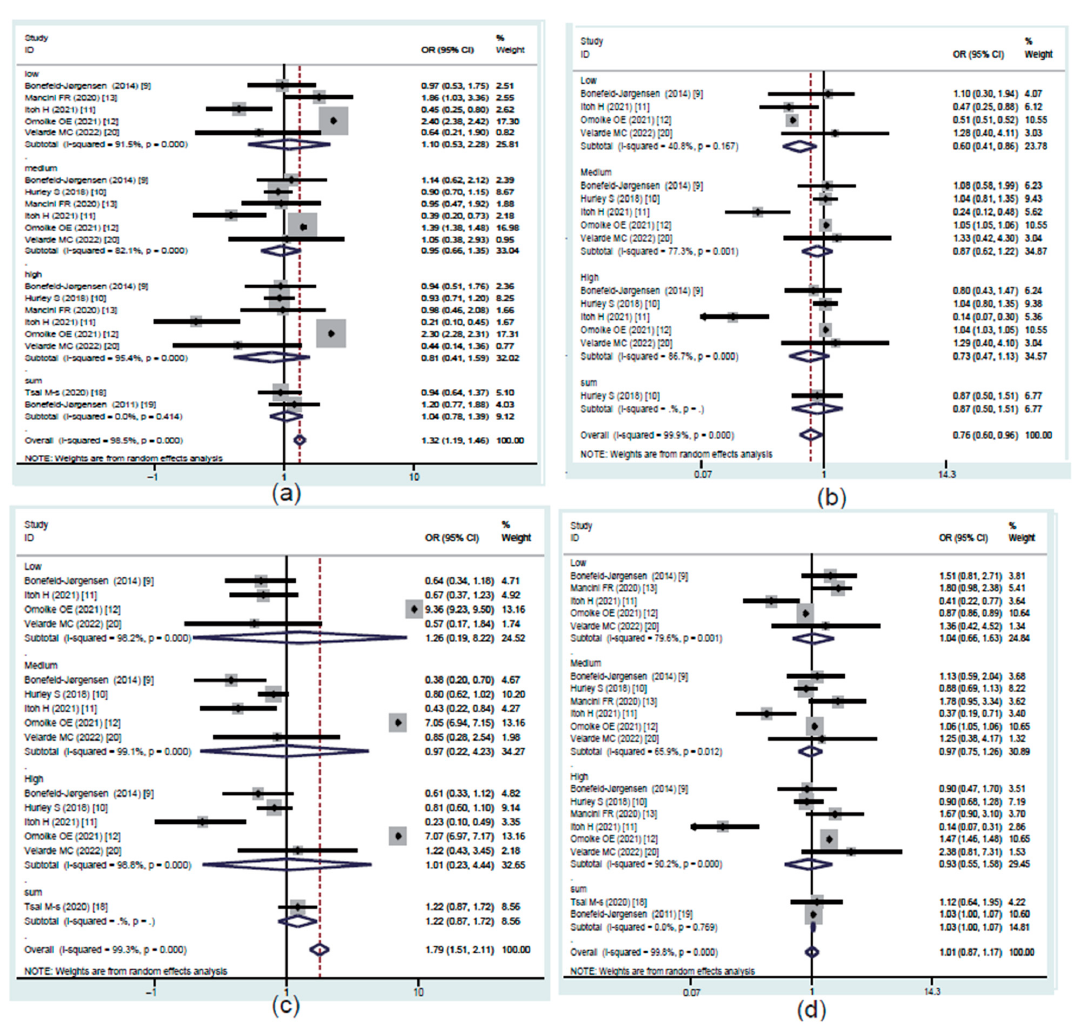
Figure 2. Forest plot of the studies that evaluated the ORs of PFASs. ( a ) PFOA; ( b ) PFNA; ( c ) PFHxS; ( d )